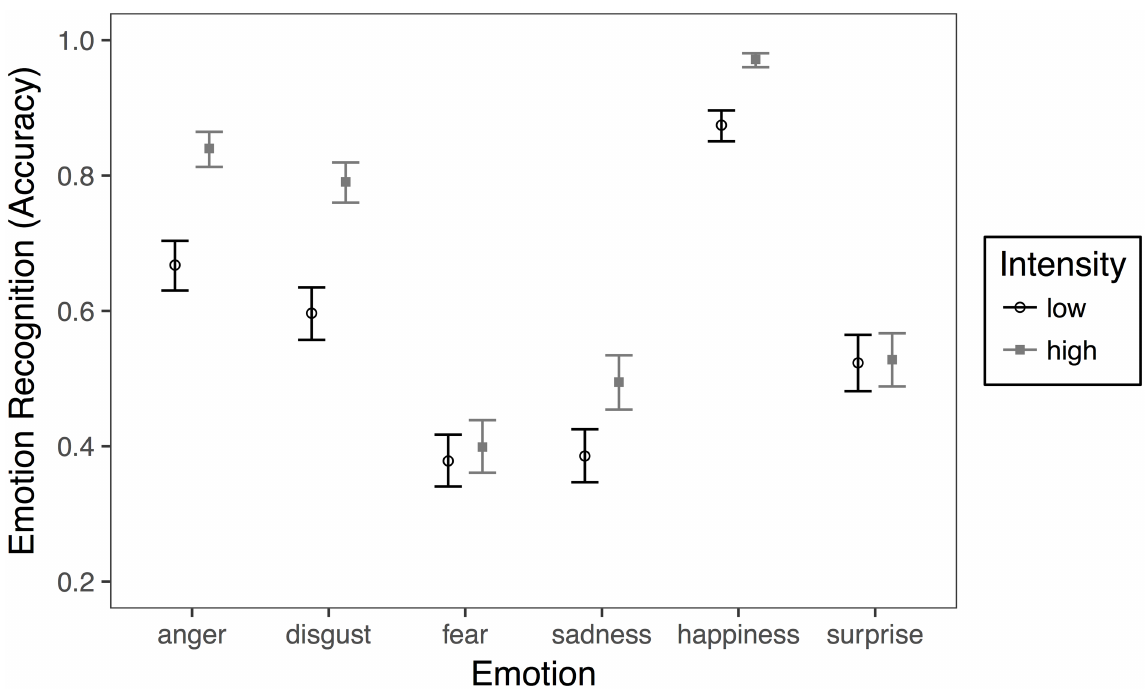
Fig 1. Estimated mean proportions of correctresponses by emotion and intensity. Error bars represent 95% Bayesian credible intervals (n subjects = 117, n observations =